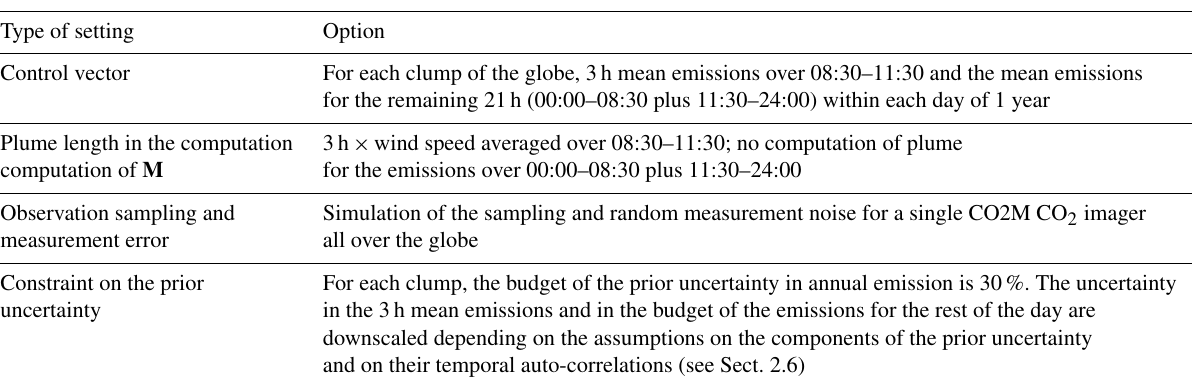
Observation sampling and measurement error Simulation of the sampling and random measurement noise for CarbonSat near Paris Prior uncertainty emissions of different days are ignored for the diagnostics Table 2. The different options for the configuration of PMIF-Globe inversions. Type of setting Option Control vector